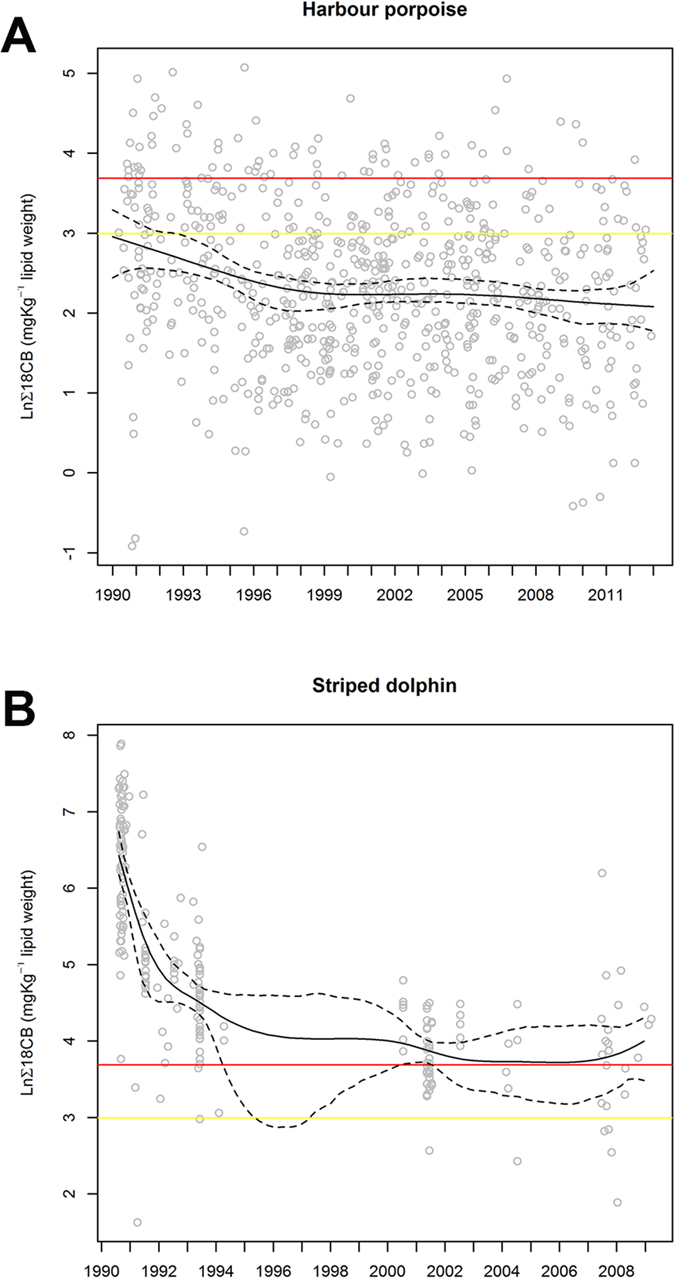
Temporal trends in ∑PCBs in UK-stranded harbour porpoise (Phocoena phocoena) and striped dolphins (Stenella coeruleoalba) in the western Mediterranean Sea.To assess the ∑PCBs trend we have fitted a Generalised Additive Model (GAM) to the data using the R (R Development Core Team, 2013) package mgcv. We used thin plate regression splines to do the smoothing and the degree of smoothing was determined by generalised cross validation. (A) Ln ∑PCBs (sum 18–25CB) mg/kg lipid concentrations in UK harbour porpoise blubber against date for all data for 1990–2012 (n = 706). The continuous line represents the smoothed trend from a Generalized Additive Model fitted to the data. The trend is statistically significant (p < 0.001, F = 11.76, residual df = 701.97, trend df = 3.03) against the null hypothesis of no trend. The dashed lines represent the 95% bootstrapped Confidence Intervals. The yellow line represents ln ∑PCBs equivalent to 20.0 mg/kg lipid and the red line 40 mg/kg lipid. (B) Ln ∑PCBs (sum 18–25CB) lipid concentrations in biopsied striped dolphin blubber from the Mediterranean Sea against date for all data for 1990–2009 (n = 220). Figure shows the natural logs (ln) of the whole data set plotted against the date found. The continuous line represents the smoothed trend from a Generalized Additive Model fitted to the data. The trend is statistically significant (p < 0.001, F = 55.45, residual df = 212.03, trend df = 6.97) against the null hypothesis of no trend. The dashed lines represent the 95% bootstrapped Confidence Intervals. The yellow line represents ln ∑PCBs equivalent to 20.0 mg/kg lipid and the red line 40 mg/kg lipid.